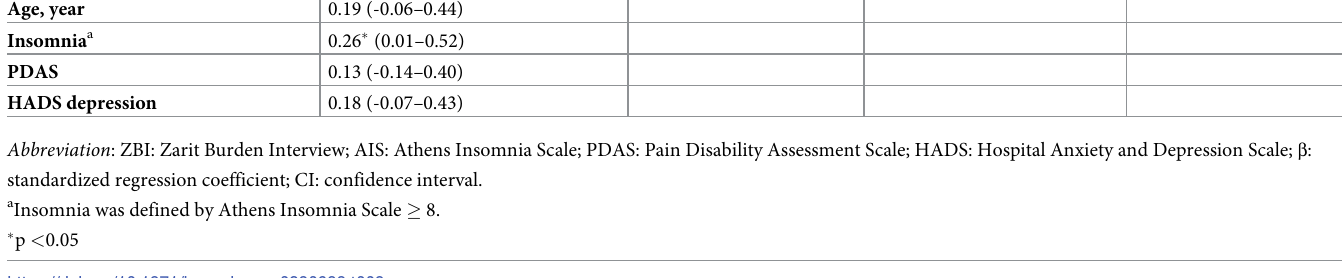
regression showed that age, PDAS scores, insomnia, and HADS depression scores were signifi- cant predictors of ZBI scores. Of these significant predictors, the multiple regression showed that insomnia in chronic pain patients significantly predicted family caregiver burden (stan- dardized regression coefficient [ β ] = 0.27, p = 0.001). Pain duration, pain-related disability, and pain intensity were not associated with family caregiver burden. The insomnia subtypes that predicted family caregiver burden in the univariate and multi- ple regressions are shown in Tables 4 and 5, respectively. Of the AIS subscales, the univariate regression identified the following significant predictors of caregiver burden (ZBI score): awakening during the night ( β = 0.30, p = 0.02), final awakening earlier than desired ( β = 0.26, p = 0.04), and functioning during the day ( β = 0.40, p = 0.002). Of these predictors, the multi- ple regression showed that functioning during the day significantly predicted family caregiver burden ( β = 0.32, p = 0.007). The subgroup analysis showed that for chronic neuropathic pain (n = 31), only insomnia predicted ZBI score ( β = 0.43, p < 0.05) (S1 Table). For chronic musculoskeletal pain (n = 11), insomnia did not significantly contribute to ZBI score (S2 Table).